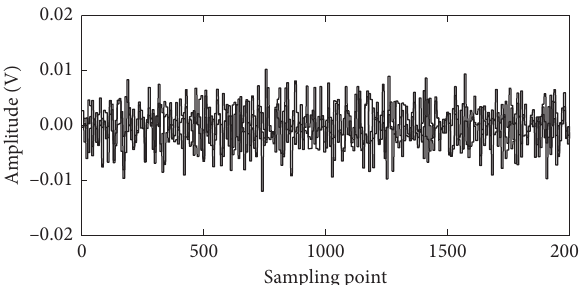
Figure 7: Upstream leakage noise reduction